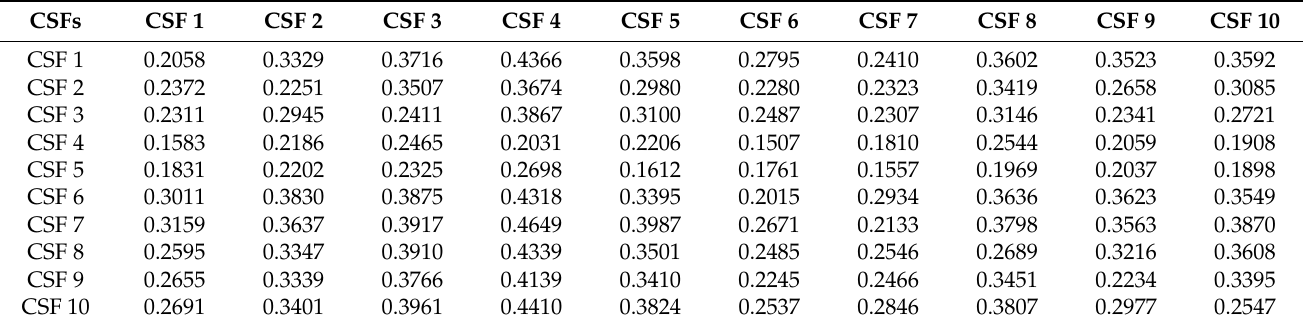
Table 6. The total relation matrix